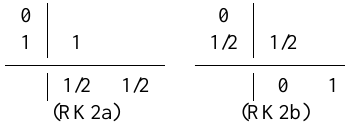
Table 2. Examples of two stage, second order explicit Runge-Kutta